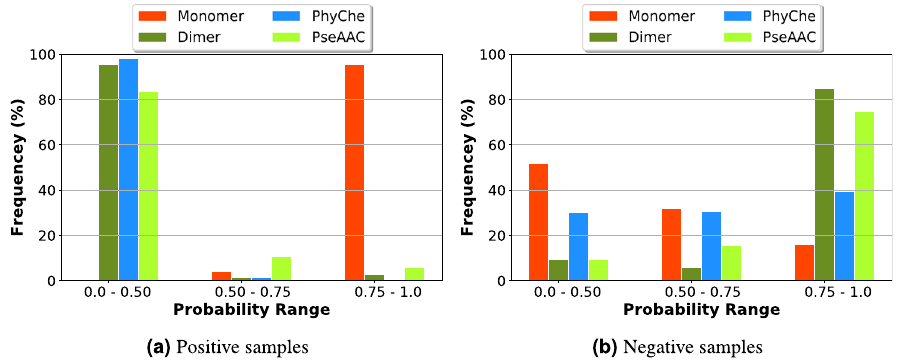
Figure 5. Feature significance analysis for 6mA site identification in positive and negative samples of benchmark dataset.